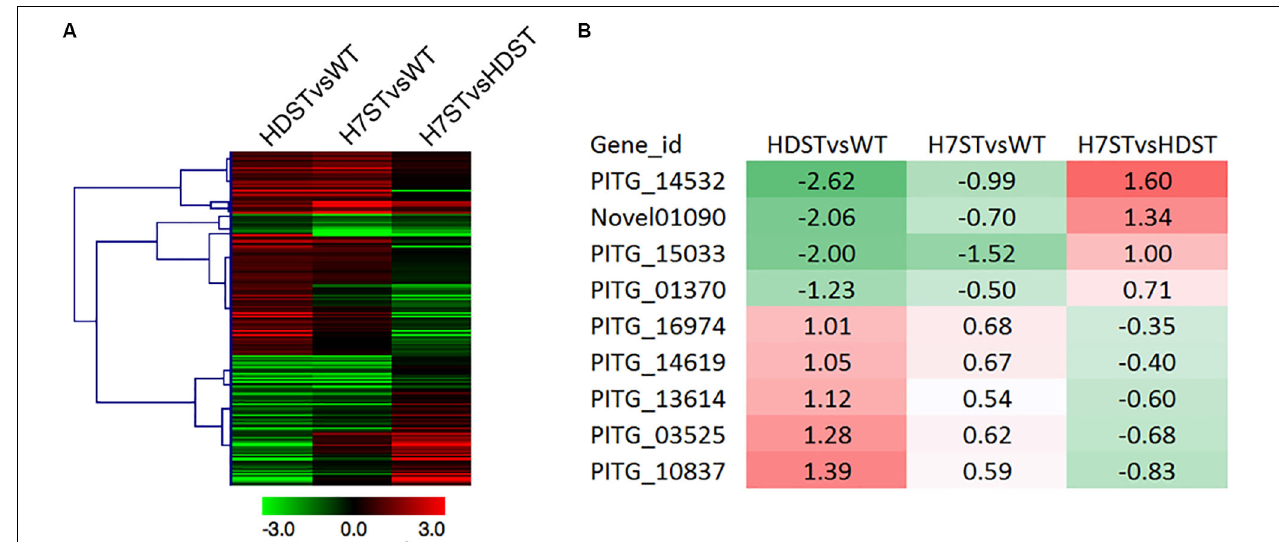
FIGURE 6 | Expression of the genes related to terpene biosynthesis. (A) Heat map presenting the expression of 210 genes related to terpene biosynthesis. (B) Heat map presenting the expression of nine candidate genes associated with α hormone biosynthesis. Red and green denote genes with up- and down-regulated expression levels, respectively. The numbers represent the log 2 (fold-change)